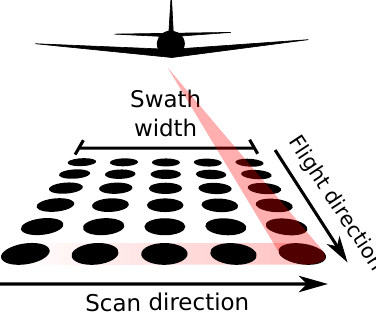
Figure 1. Conceptual illustration of airborne lidar scanning. Scan direction (scan line) is typically perpendicular to the flight direction. The area covered during scanning while an aircraft flies in a constant direction is called the swath or flight